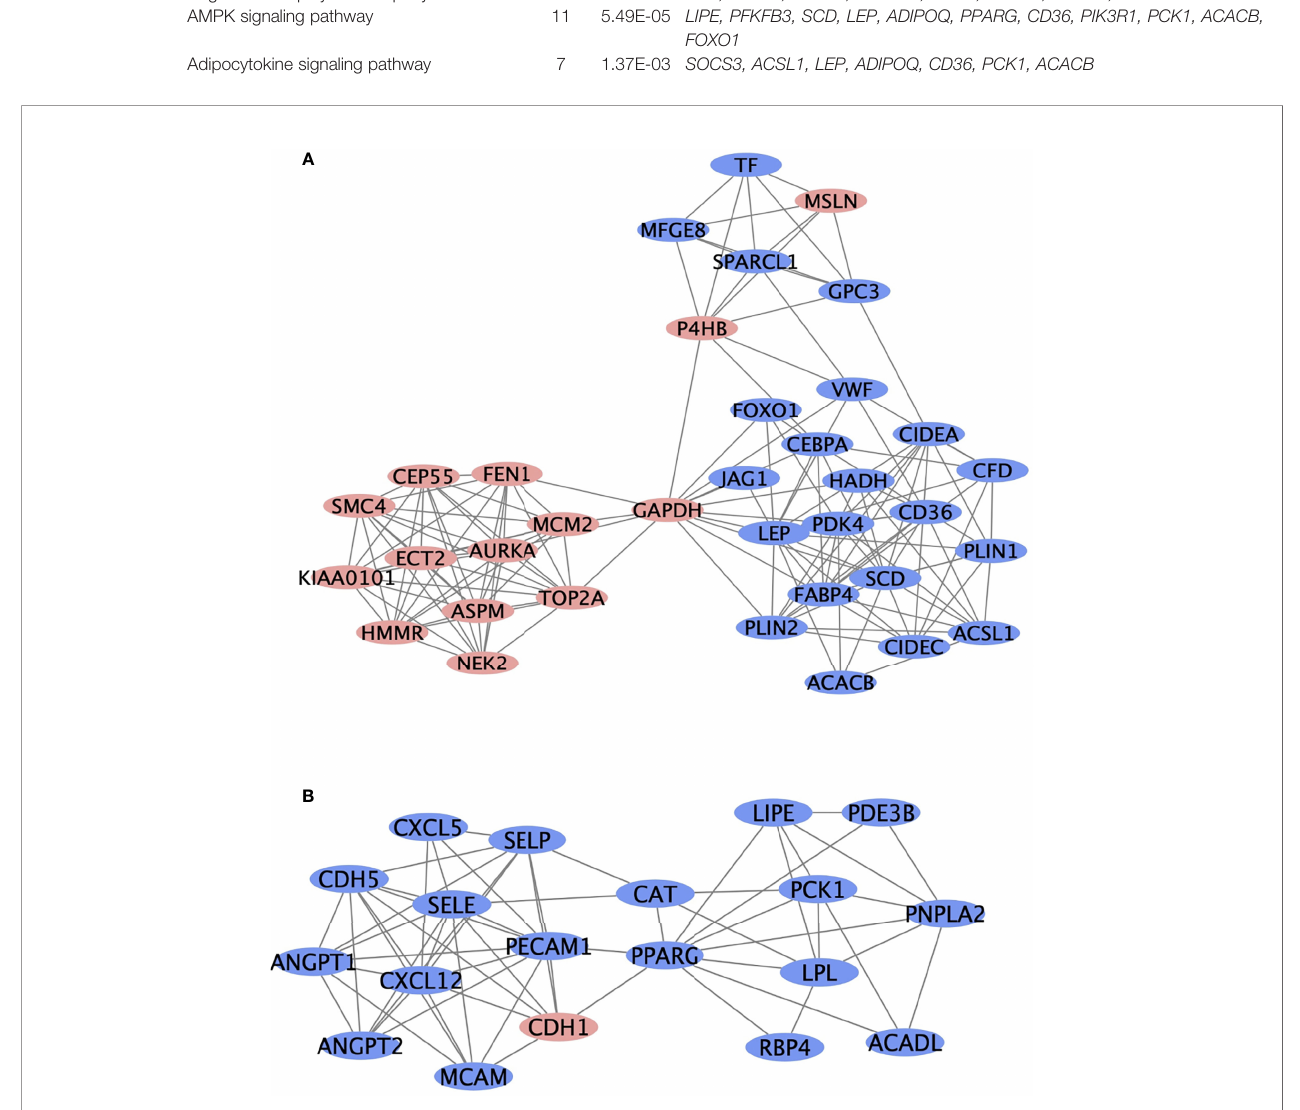
FIGURE 3 | The top two most signi fi cant modules of DEGs. The top two signi fi cant modules (A, B) are selected from the PPI network. Red nodes represent upregulated genes, and blue nodes represent downregulated